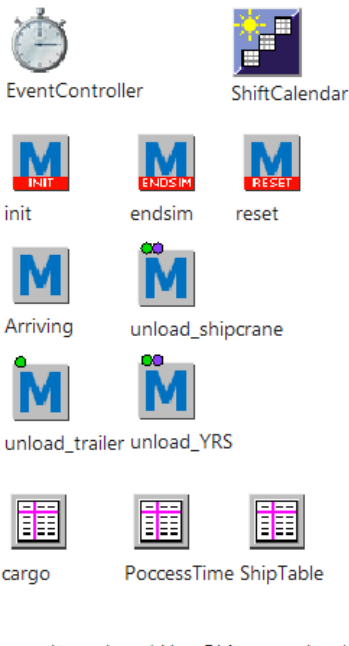
Figure 8. Control & information